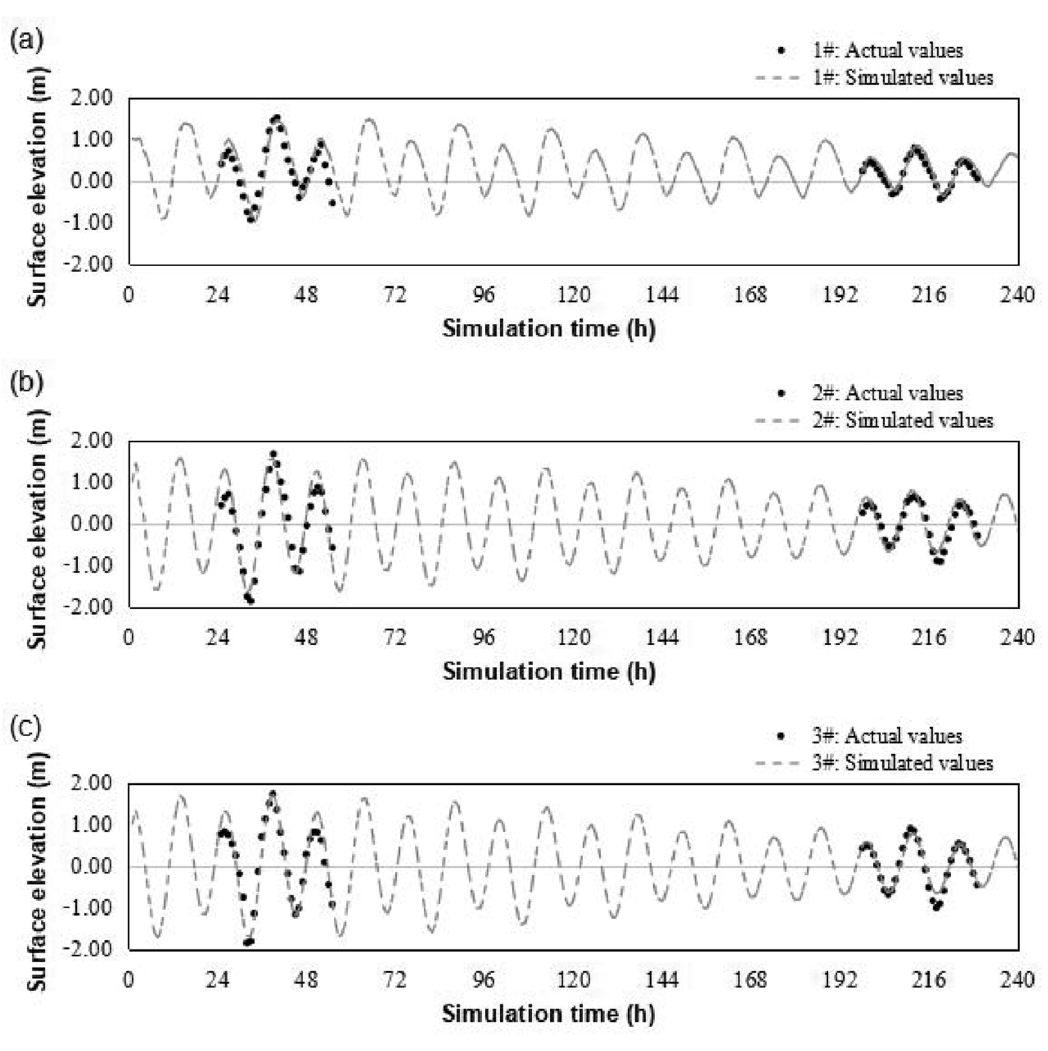
Figure 5. Tide Level Verification by comparison of simulated water level and the measured water level values at the three observation stations: Zhenhai ( a ), Zhenhaikou ( b ), and Dong’ao ( c ).